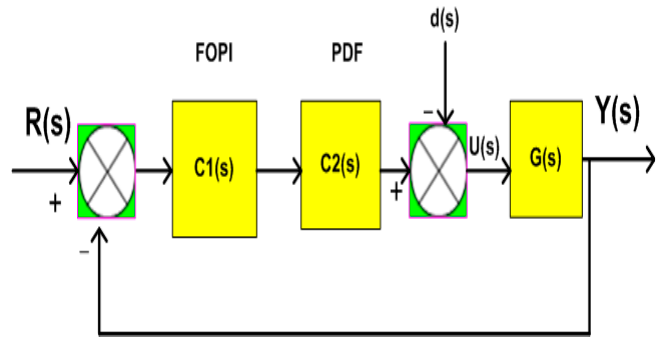
Figure 7. Cascaded form of controller.